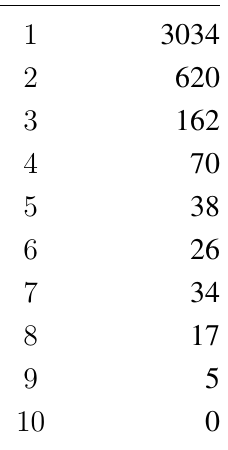
Table 6. number of nodes simultaneously violating local constraints. for feature “bosnia” with threshold r = 0 . 0025 , and l 2